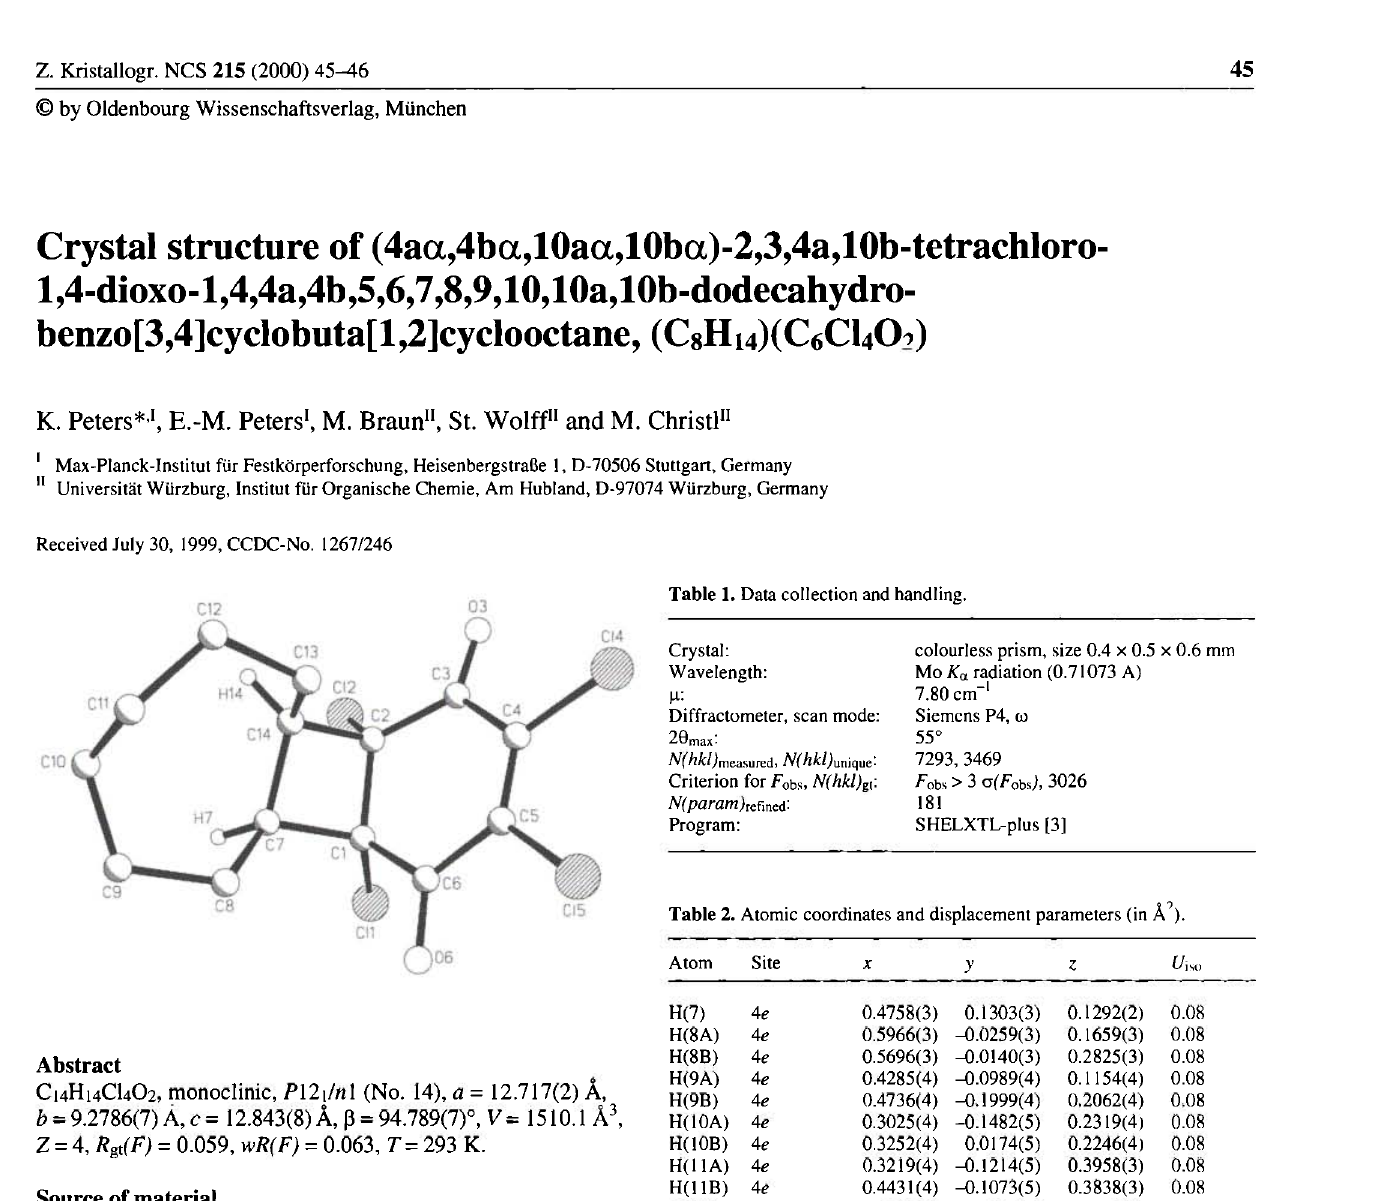
Table 3. Atomic coordinates and displacement parameters (in Ä 2